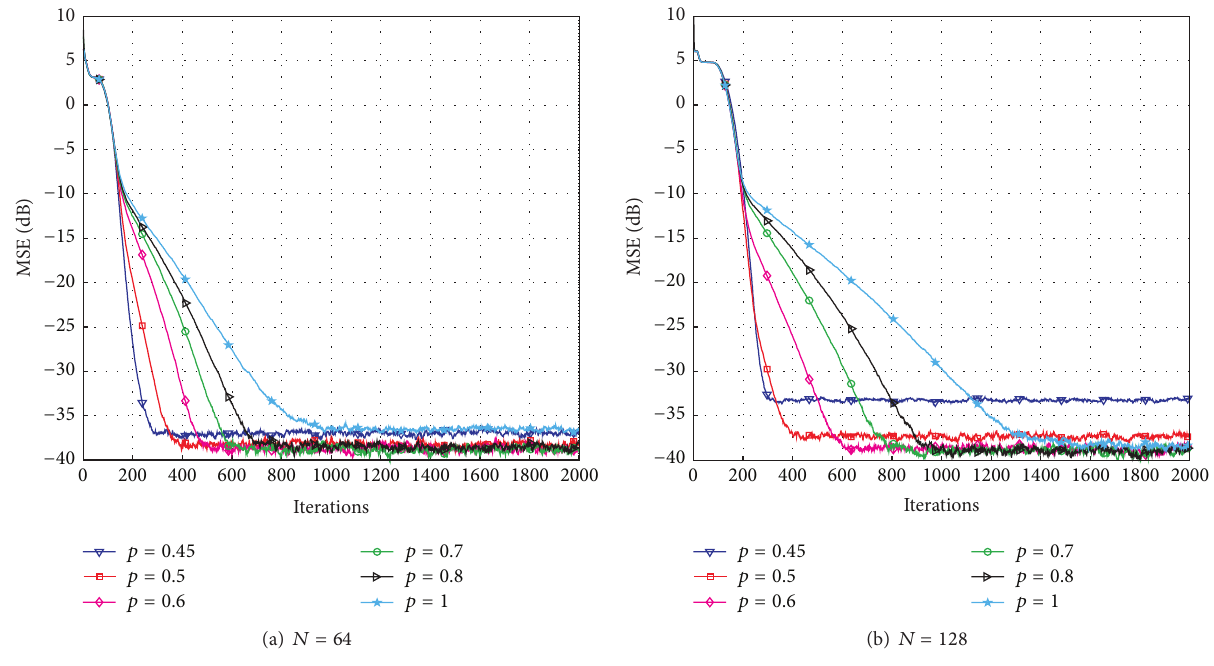
Figure 4: Effects of 𝑝 on the proposed LP-PNLMS algorithm.